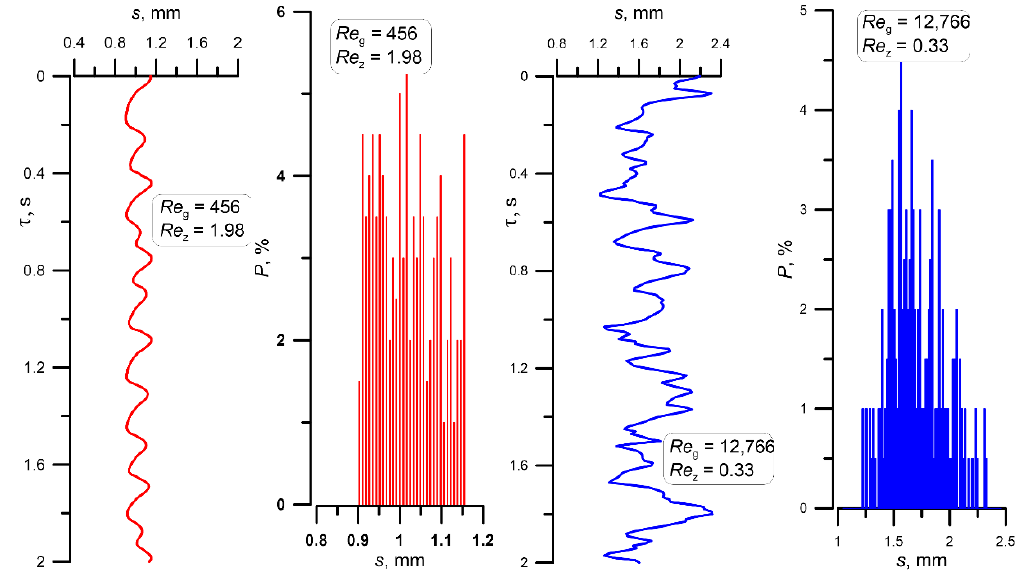
Figure 11. Exemplary study results of surface state and thickness distribution of the liquid film. The average of the measured film thickness was assumed as the integral mean.